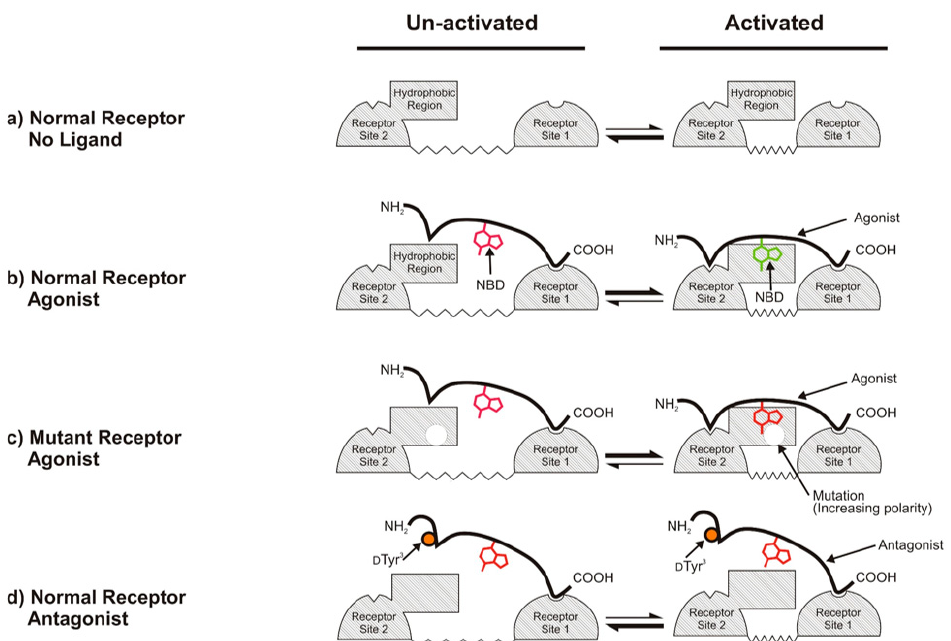
Figure 7. Model for the binding and activation of normal and mutant α -factor receptors by different ligands. Ligand-interacting surfaces on the receptor are indicated by cross-hatching. Site I interacts with the C-termini of ligands and is likely to consist of the extracellular end of the first transmembrane segment. Site 2 interacts with the N-terminus of ligands and most likely consists of the extracellular end of the sixth transmembrane segment and the third extracellular loop of the receptor. The conformational equilibrium between the inactive and activated states of the receptor is represented as a change in the distance between Site 1 and Site 2. ( a ) In the absence of ligand, the receptor favors the inactivated state with a large separation between ligand contact sites. ( b ) Binding of the agonist to normal receptors favors the activated state. ( c ) Mutations affecting the emission spectrum of bound agonist change the environment of the fluorophore (red shift) without altering the receptor ligand binding or, generally, activation. ( d ) Binding of ligands that act as antagonists toward normal receptors (labeled antagonist) does not alter the conformational equilibrium of the receptor. Activation-specific interactions with the N-terminus of the ligand are blocked by the D -Tyr 3 substitution (orange circle), leaving the NBD group attached at Lys 7 exposed to the solvent, and the C-terminal region of the antagonist (which is identical to the corresponding region of agonist) maintains a high-affinity interaction with the receptor. Adapted with permission from [71].